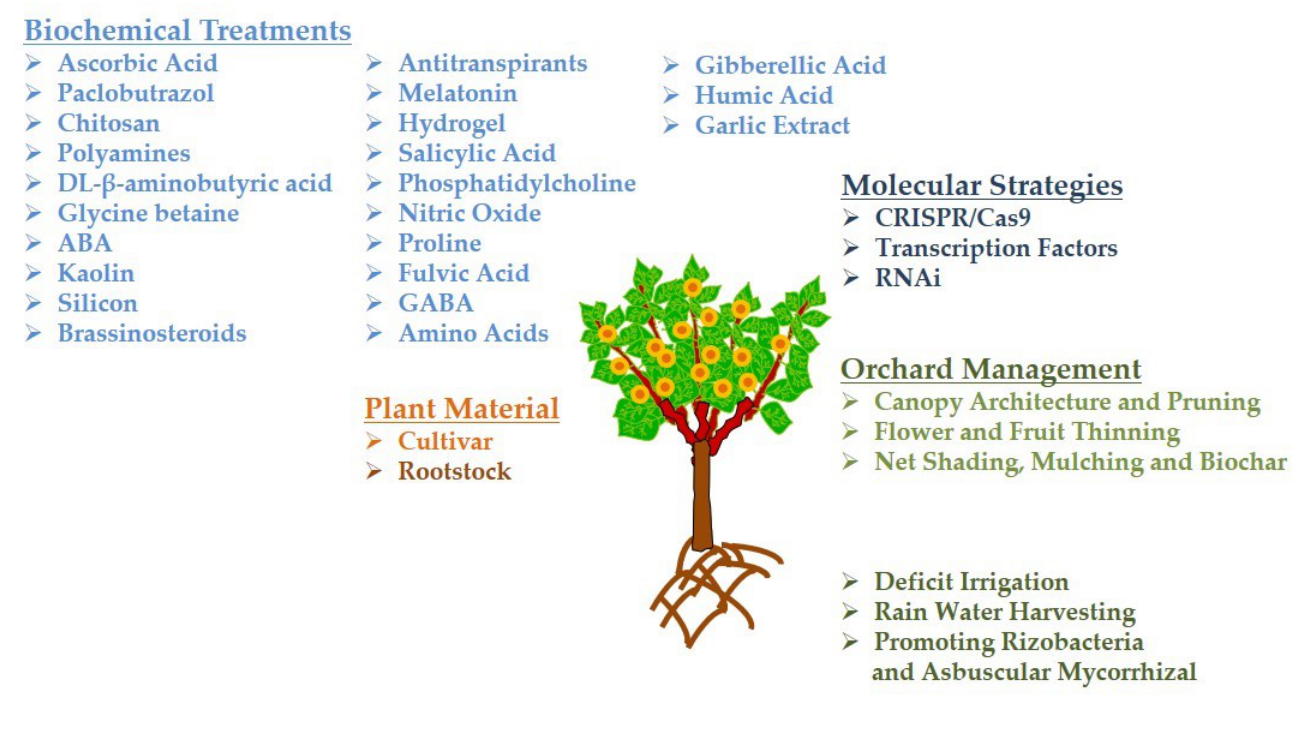
Figure 1. New Horticultural, Biochemical, and Molecular Strategies for Drought Tolerance in Tem- perate Fruit